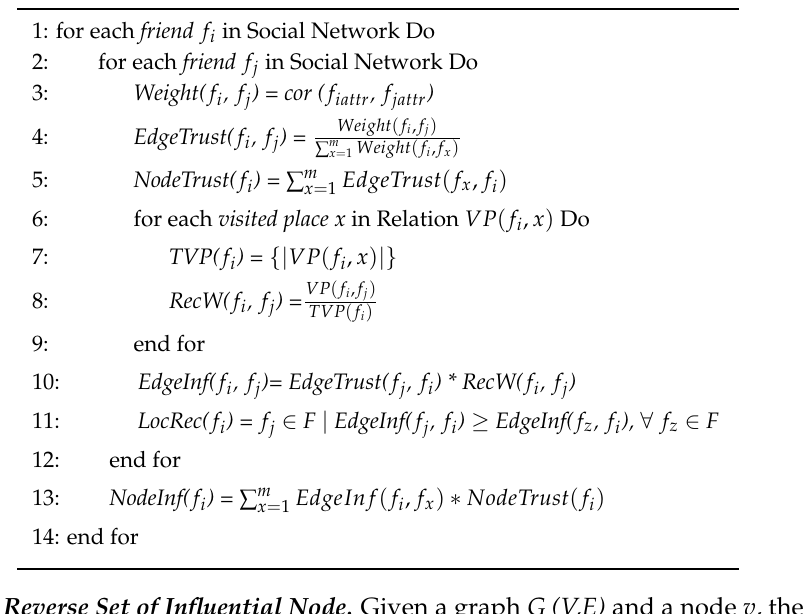
Algorithm 1: Trust-Based Location Recommendation Algorithm